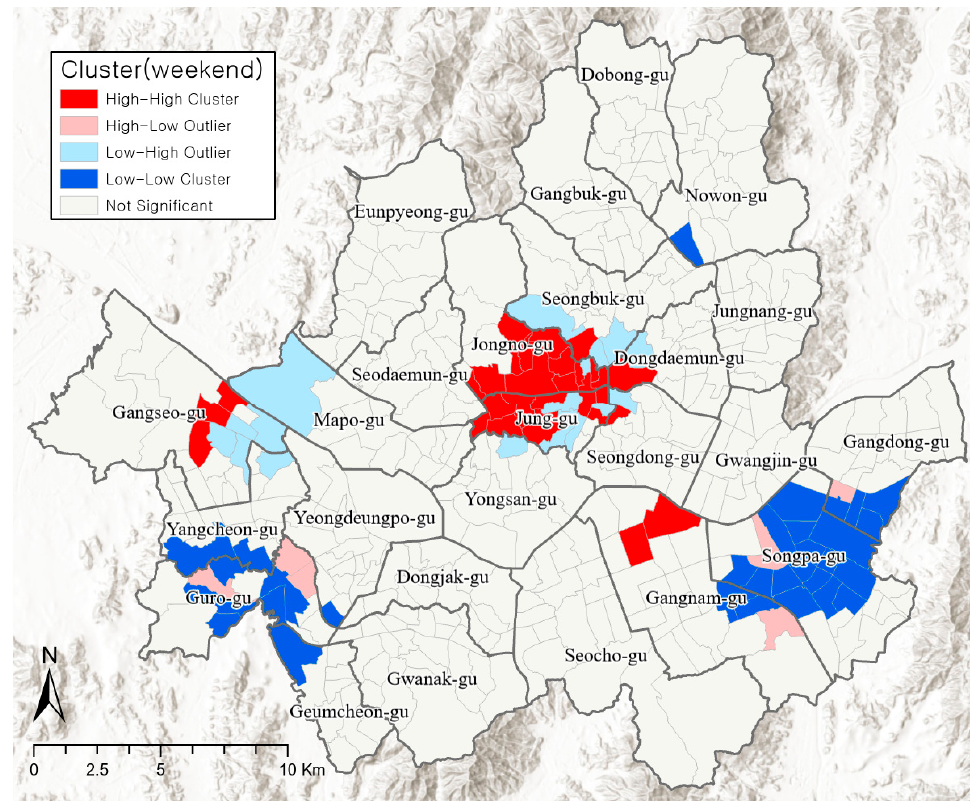
Figure 4. Clusters of visiting population changes on weekends.